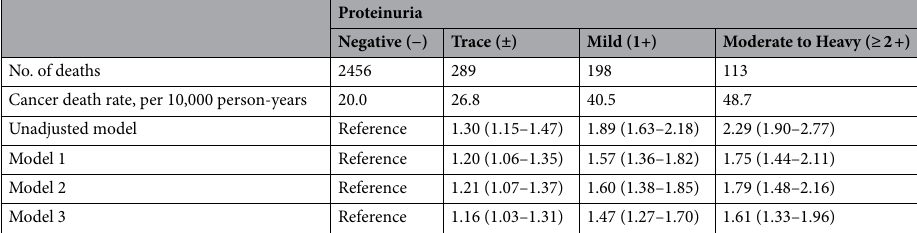
Table 2. Hazard ratios for cancer death according to level of proteinuria. Model 1 adjusted for age and sex. Model 2 adjusted for covariates in model 1 plus body mass index, current smoker, and alcohol consumption. Model 3 adjusted for covariates in model 2 plus systolic blood pressure, estimated glomerular filtration rate, hemoglobin A1c, low-density lipoprotein cholesterol, and aspartate